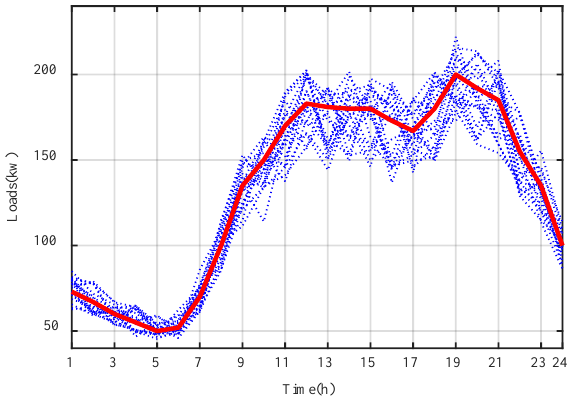
Figure 14. Forecasted demand and created loads by various scenarios.